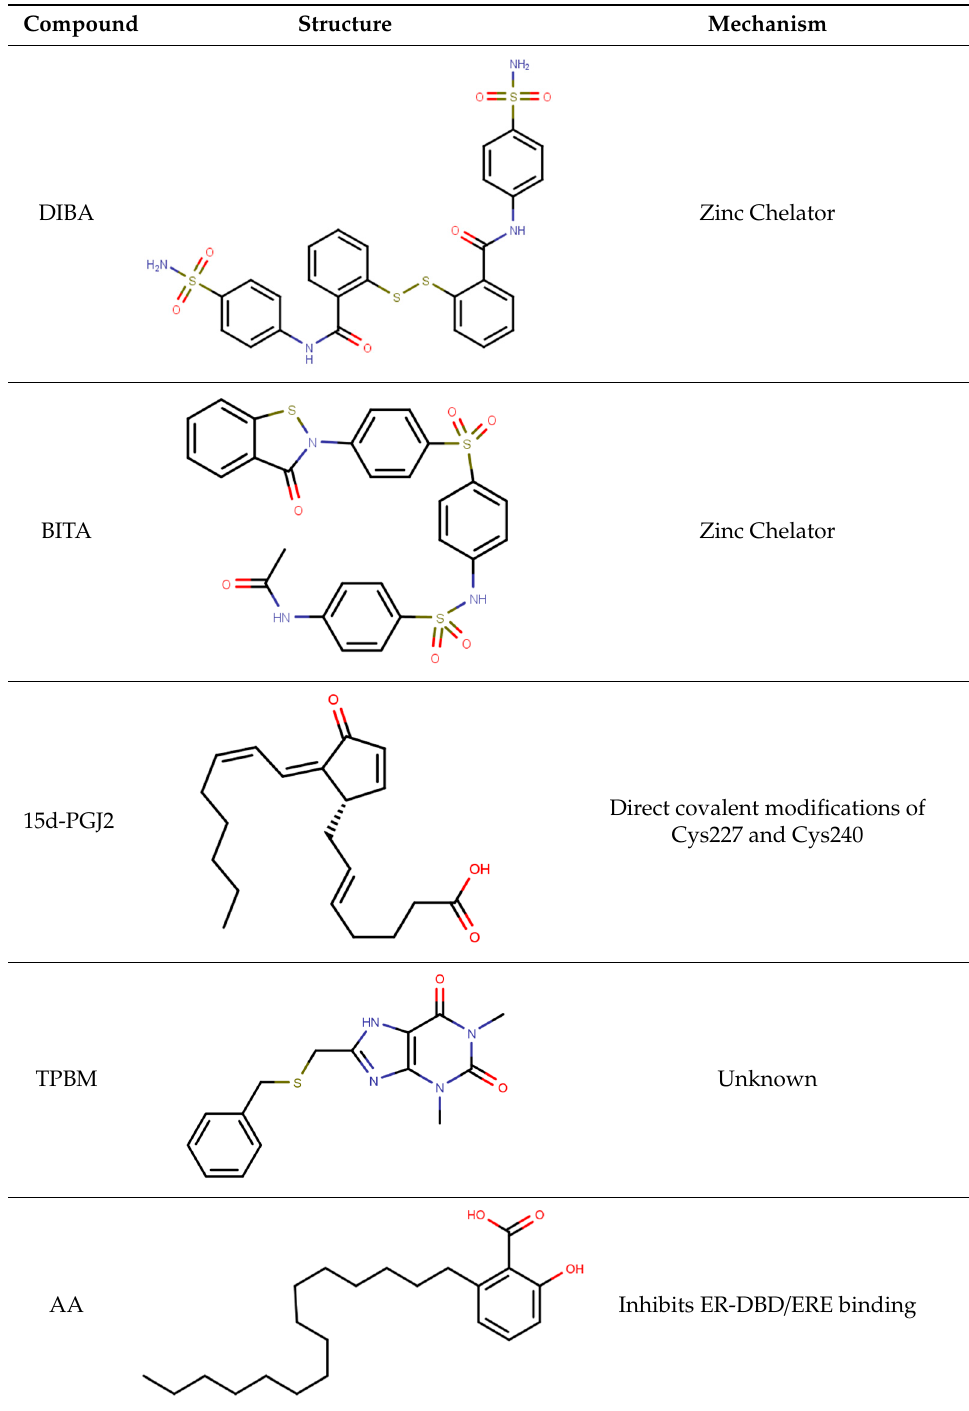
Table 7. DNA Binding Domain targeting